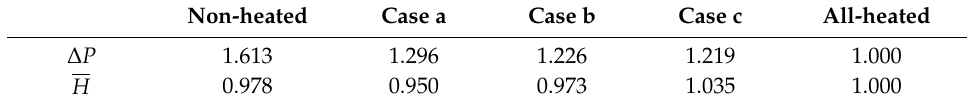
Table 3. E ff ects of heating conditions on the pressure drop and the outlet mean apparent viscosity. Non-heated Case a Case b